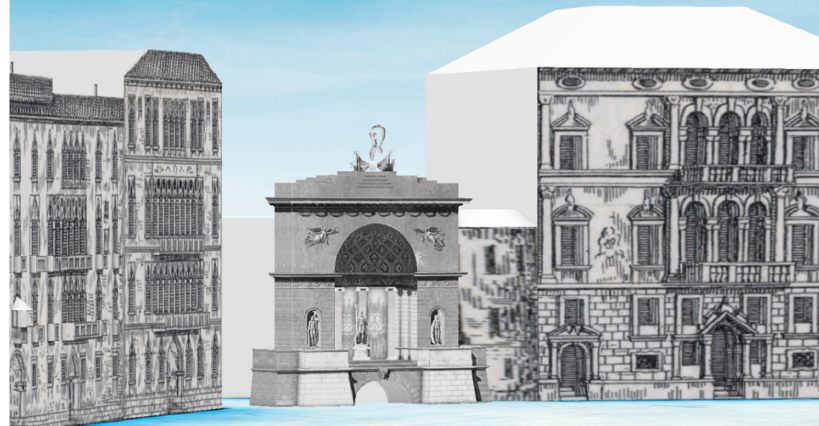
Figure 22. A view of the Grandstand inside the city